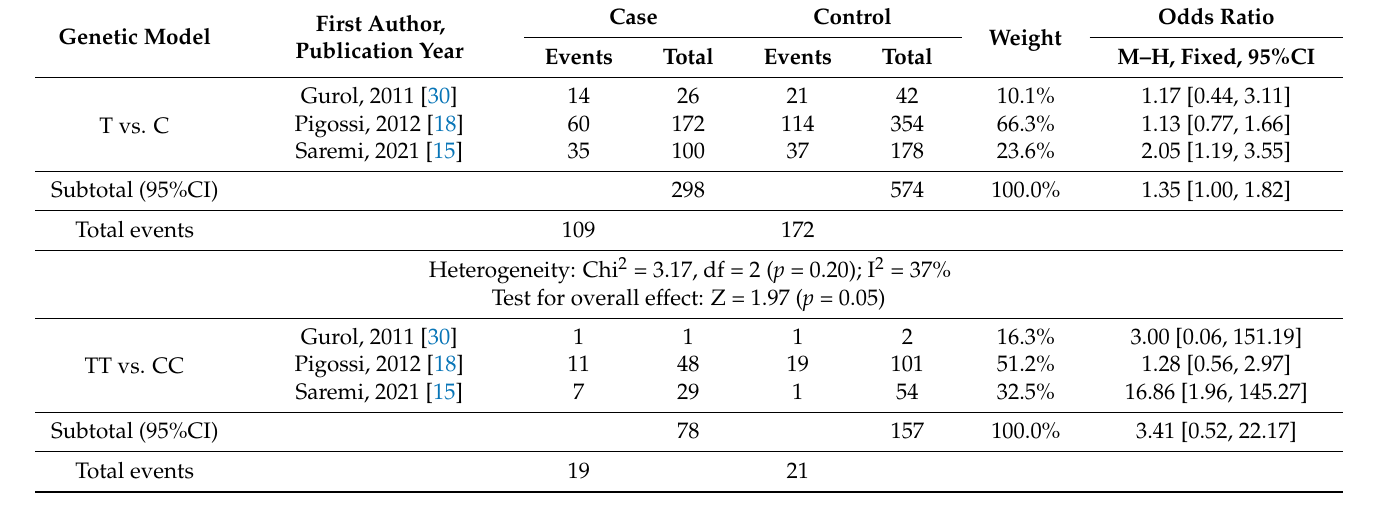
Table 5. Meta-analyses of studies involving five genetic models of IL-10 ( − 819 C > T) polymorphism and the risk of PID. Genetic